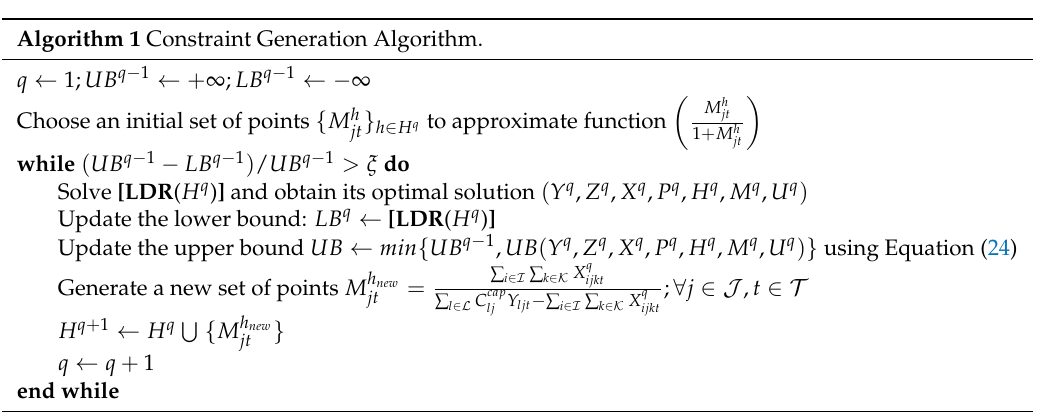
Algorithm 1 Constraint Generation